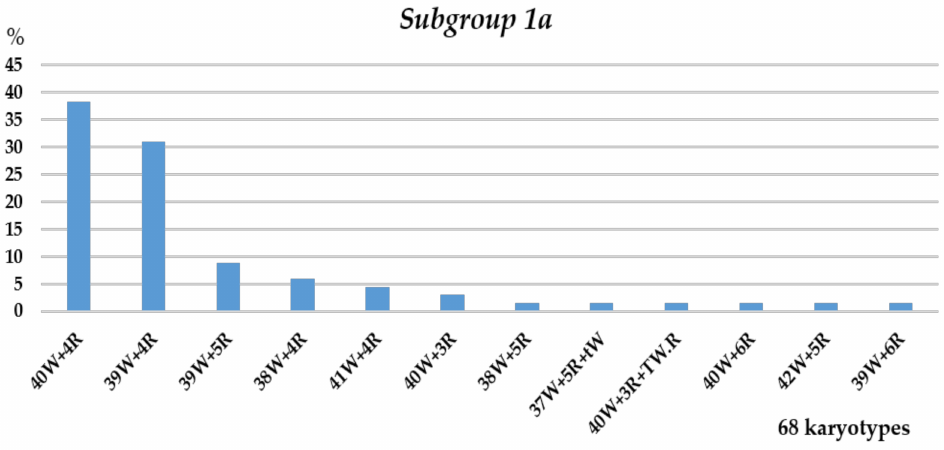
Figure 4. Frequencies of different chromosome sets in the plant karyotypes of subgroup 1a, 22-4 plant progeny. Designations: T, Robertsonian translocation; t, telocentric; W, wheat chromosomes; R, rye chromosomes.